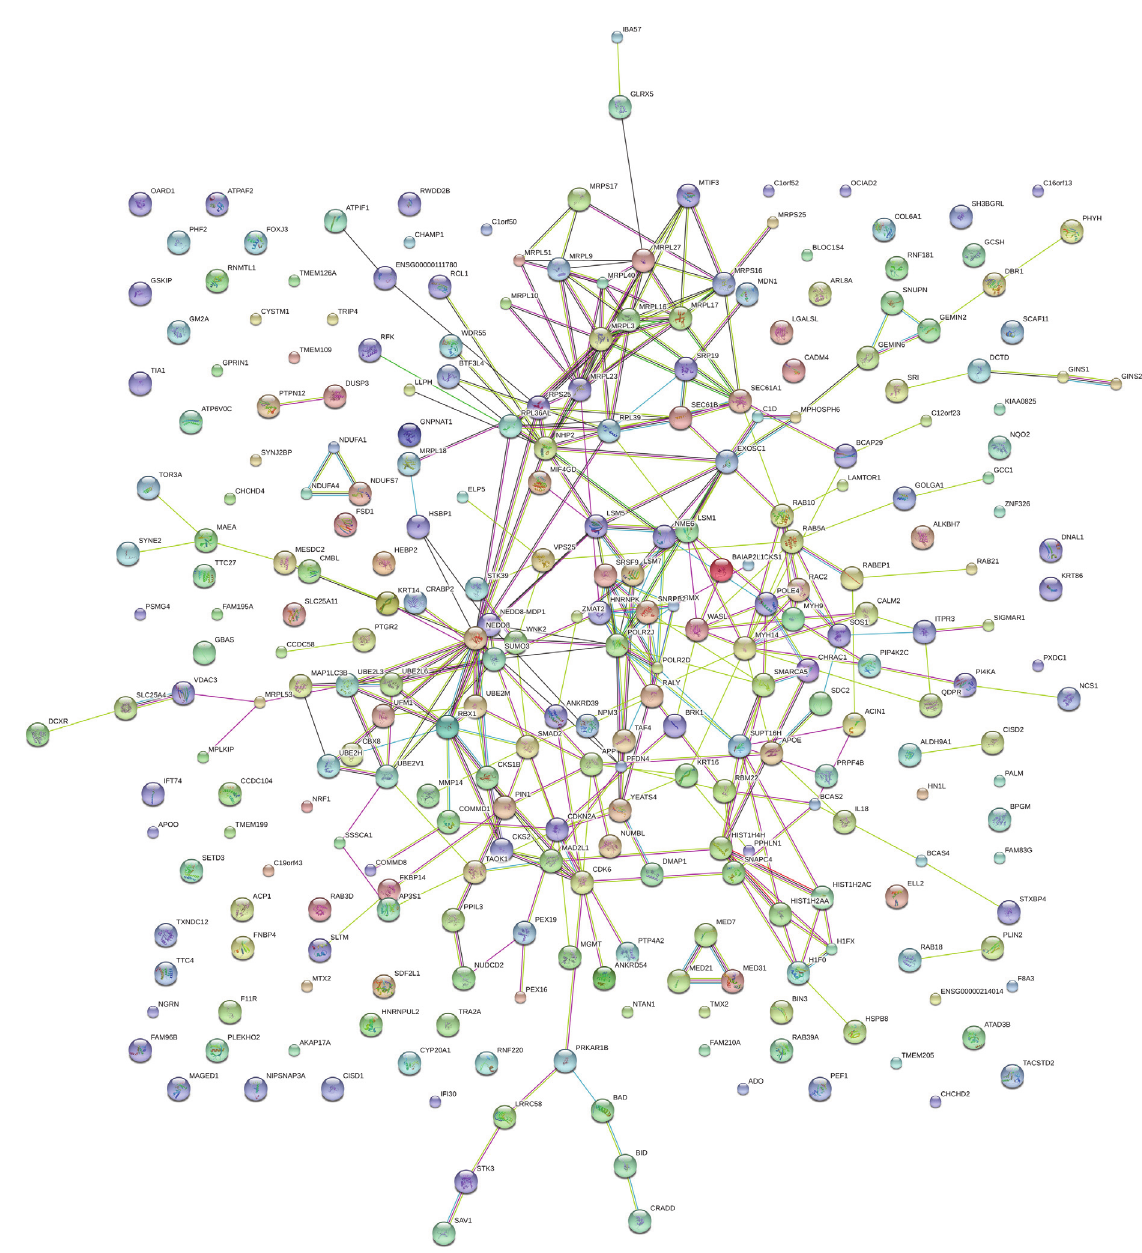
Figure 5: The differentially expressed proteins were used to search the STRING database to predict their protein-protein interactions in the deoxycholic acid treated cells. In the network, the nodes are the proteins and the lines represent the predicted functional associations. The number of lines indicates the strength of the predicted functional interactions of the